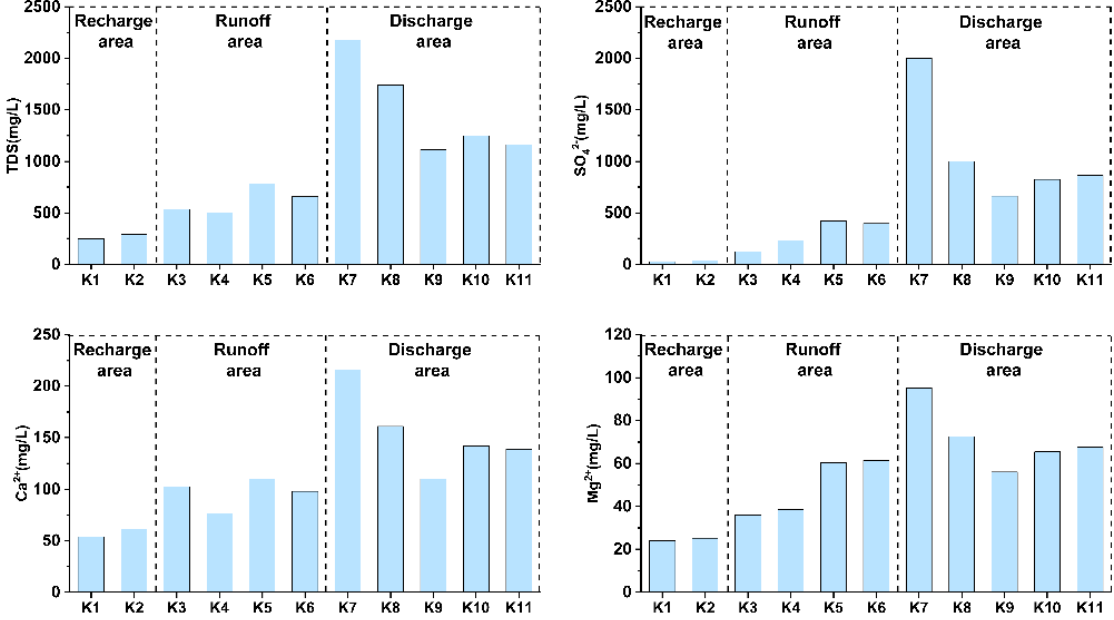
Figure 2. Distribution of TDS, SO 42 − , Ca 2+ and Mg 2+ in karst groundwater samples.